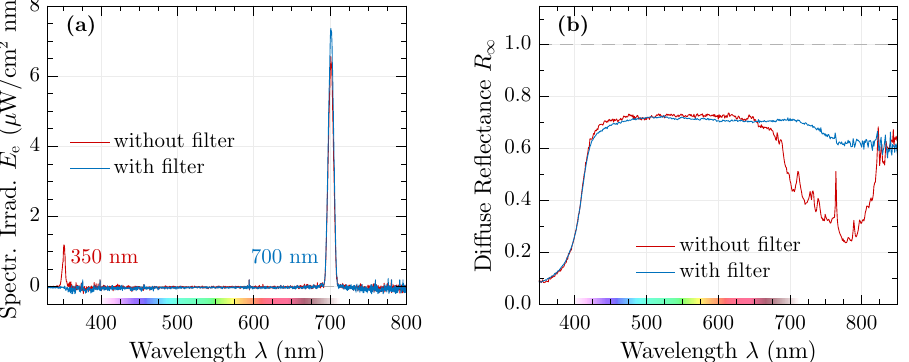
Figure 9. ( a ) Evidence of higher order diffraction for a center wavelength of 700nm, when no additional spectral filters are engaged (red) and removal of undesired wavelengths using a long-pass (LP) filter transmitting wavelengths greater than 680nm (blue). ( b ) Diffuse reflectance of a rutile-TiO 2 sample against CR30F without (red) and with (blue) spectral filtering after the excitation